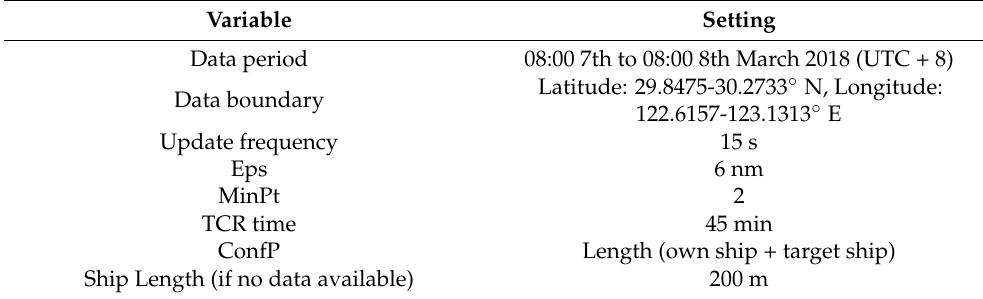
Table 1. Parameter settings for case study.